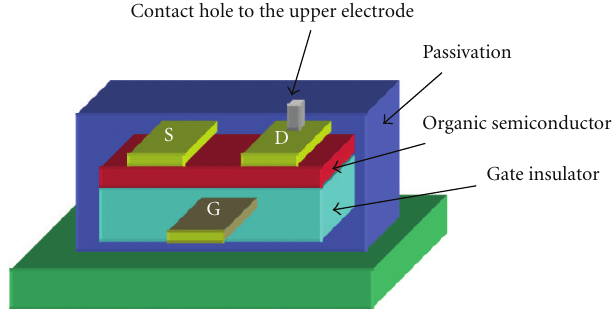
Figure 1: Device structure of O-TFT (bottom-gate/top-contact type).